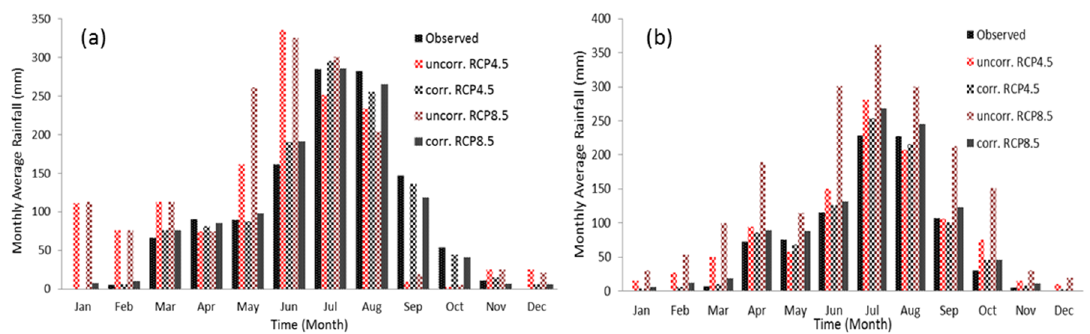
Figure 2. Bias corrected precipitation at ( a ) Addis Ababa and ( b ) Debrazeit stations.